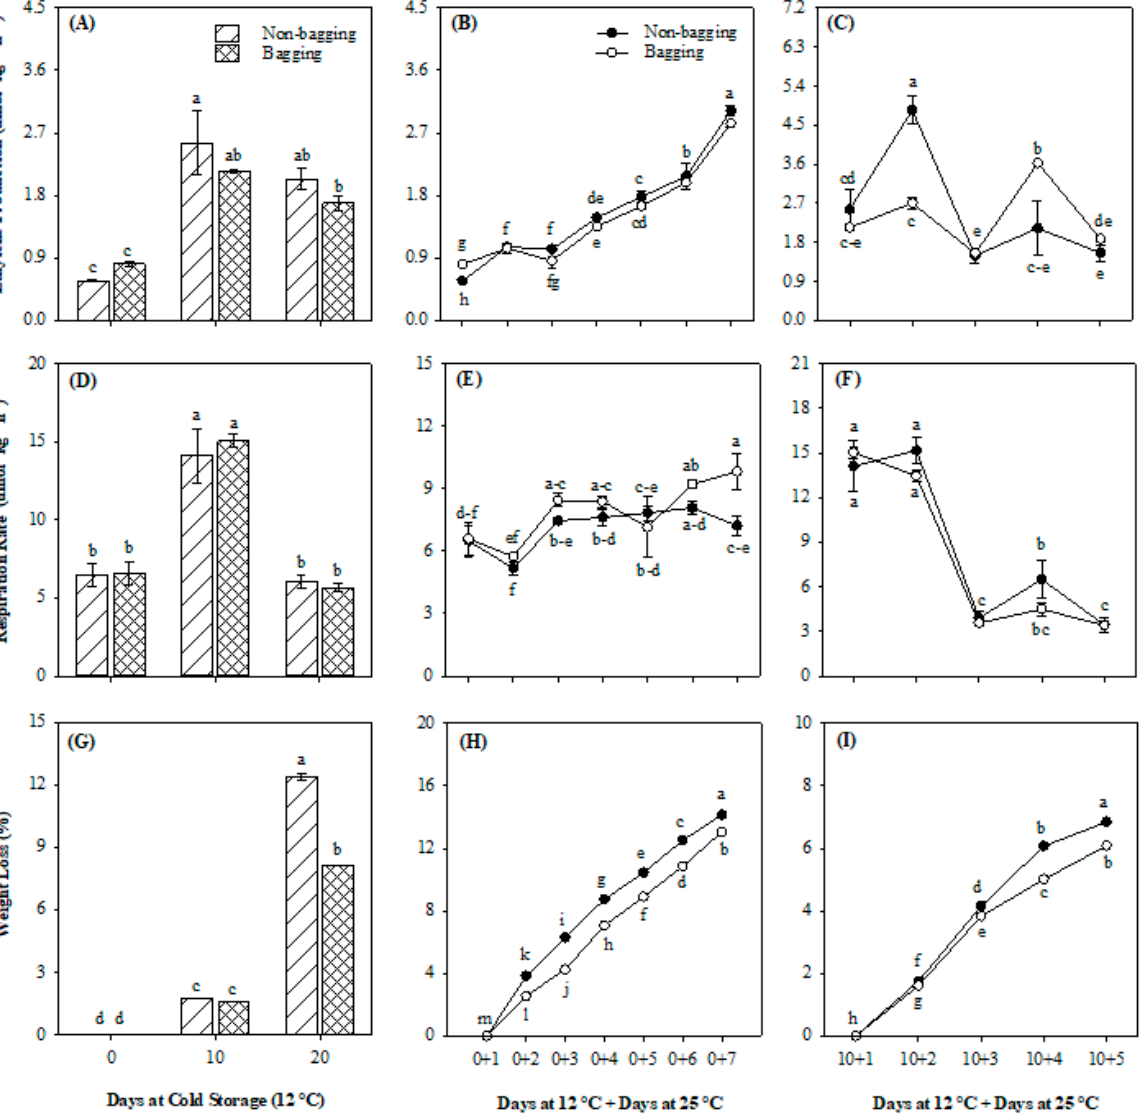
Figure 1. Effect of on-tree fruit bagging treatments on post-harvest ethylene production ( A – C ), respiration rate ( D – F ) and weight loss ( G – I ) in mango fruit during cold storage intervals and under subsequent ambient conditions. Error bars show standard errors of the means ( n = 3). Different letters indicate significant differences according to the LSD test at p ≤ 0.05. When 20-day cold-stored fruits were kept under ambient conditions, fruits were decayed within 24 h hence no tests were